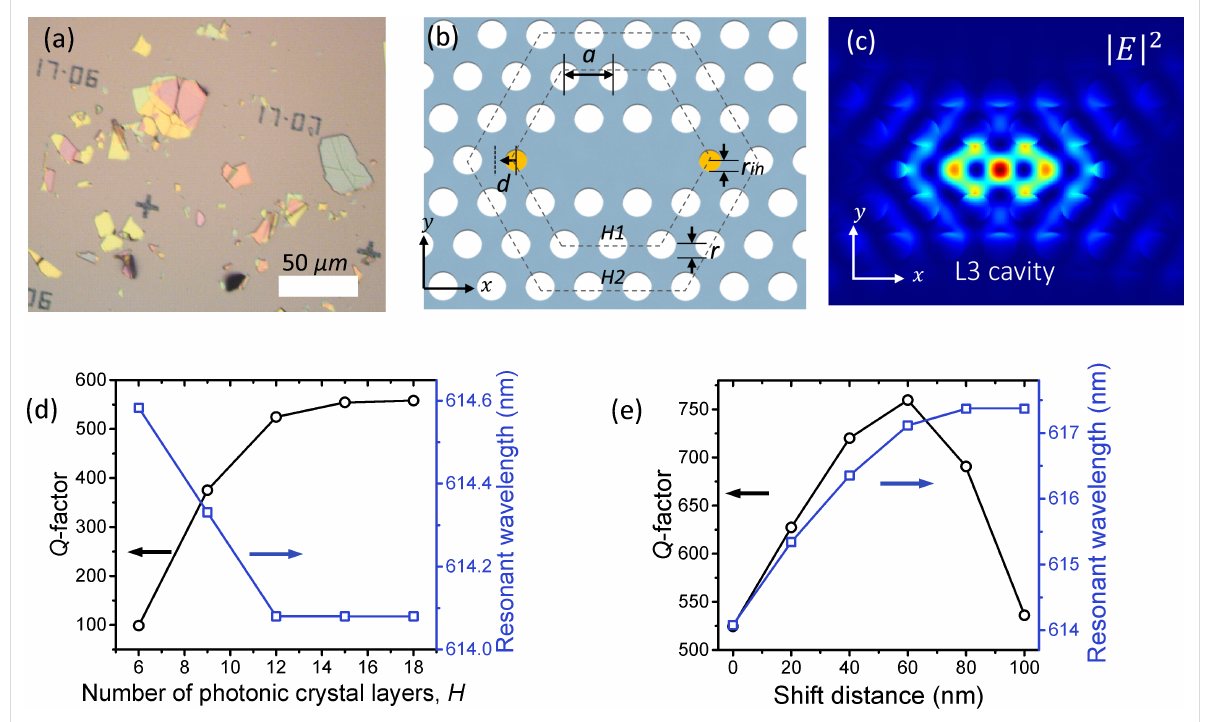
Figure 1: (a) Optical image of exfoliated hBN flakes. (b) Schematic of a 2D photonic crystal with an L3 cavity. The geometric parameters are the following: the period ‘ a ’, the radius of air holes ‘ r ’, the radius of two side air holes ‘ r in ’, the shift distance of the side air holes ‘ d ’, the thickness of the hBN slab ‘ t ’ and the number of photonic crystal layers ‘ H ’. (c) Three-dimensional FDTD simulation of the electric field intensity profile of the funda- mental mode of the L3 cavity. Q -factor and the resonant wavelength calculated as a function of (d) the number of photonic crystal layers ‘ H ’, and (e) the shift distance of the two side air holes ‘ d